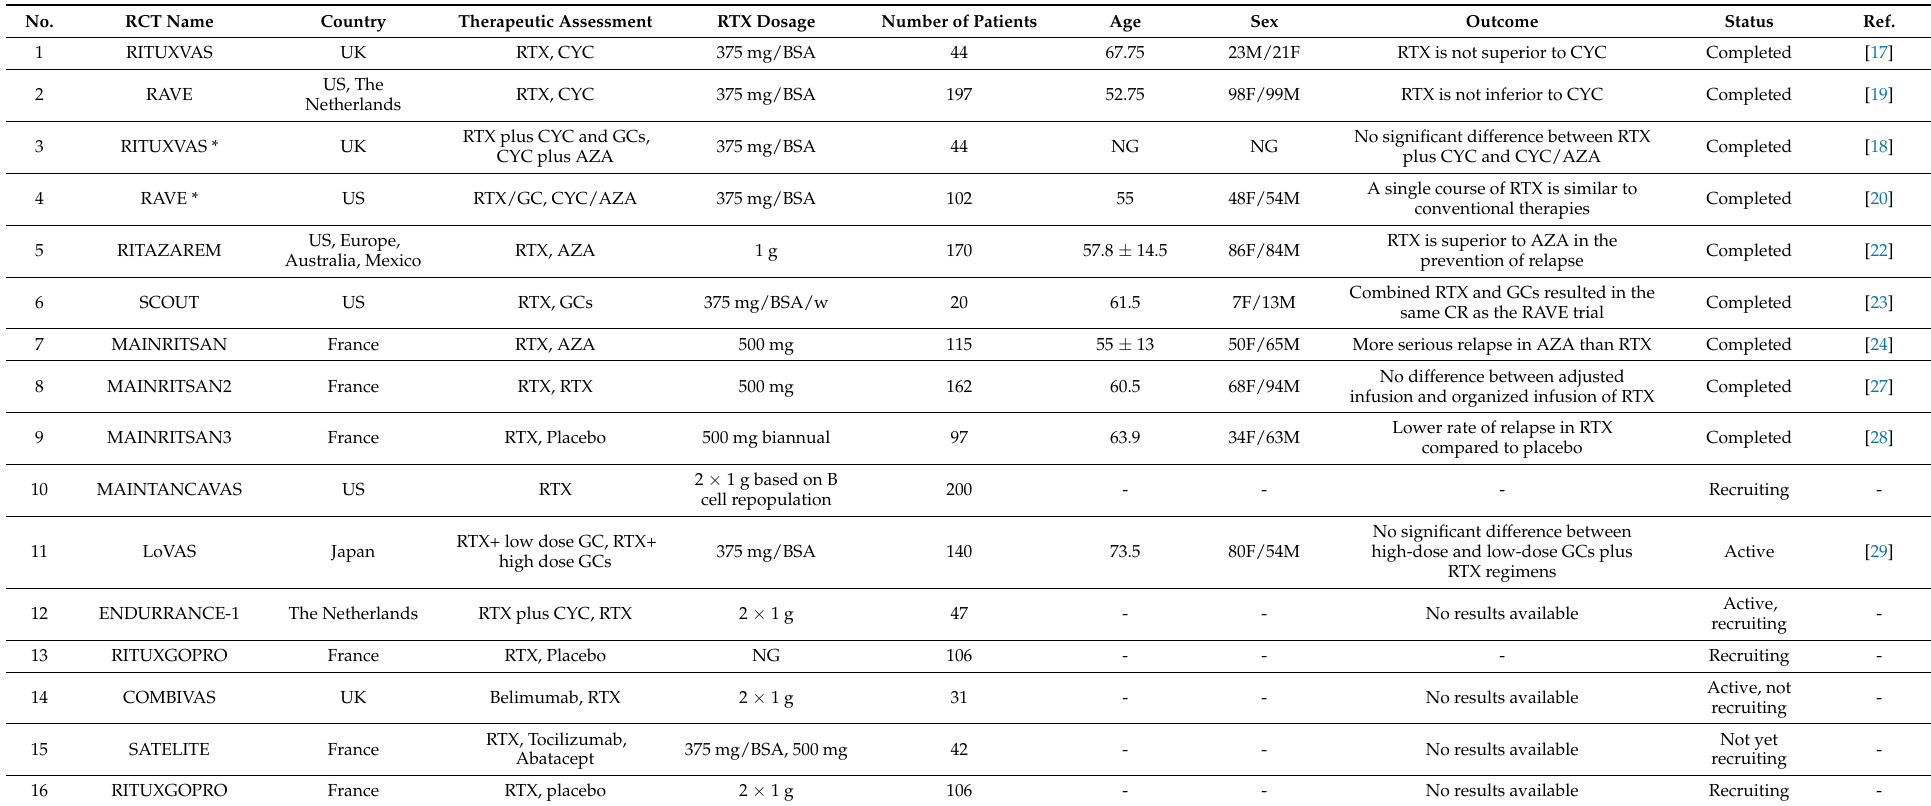
Table 1. Clinical Trials of rituximab therapy in AAV